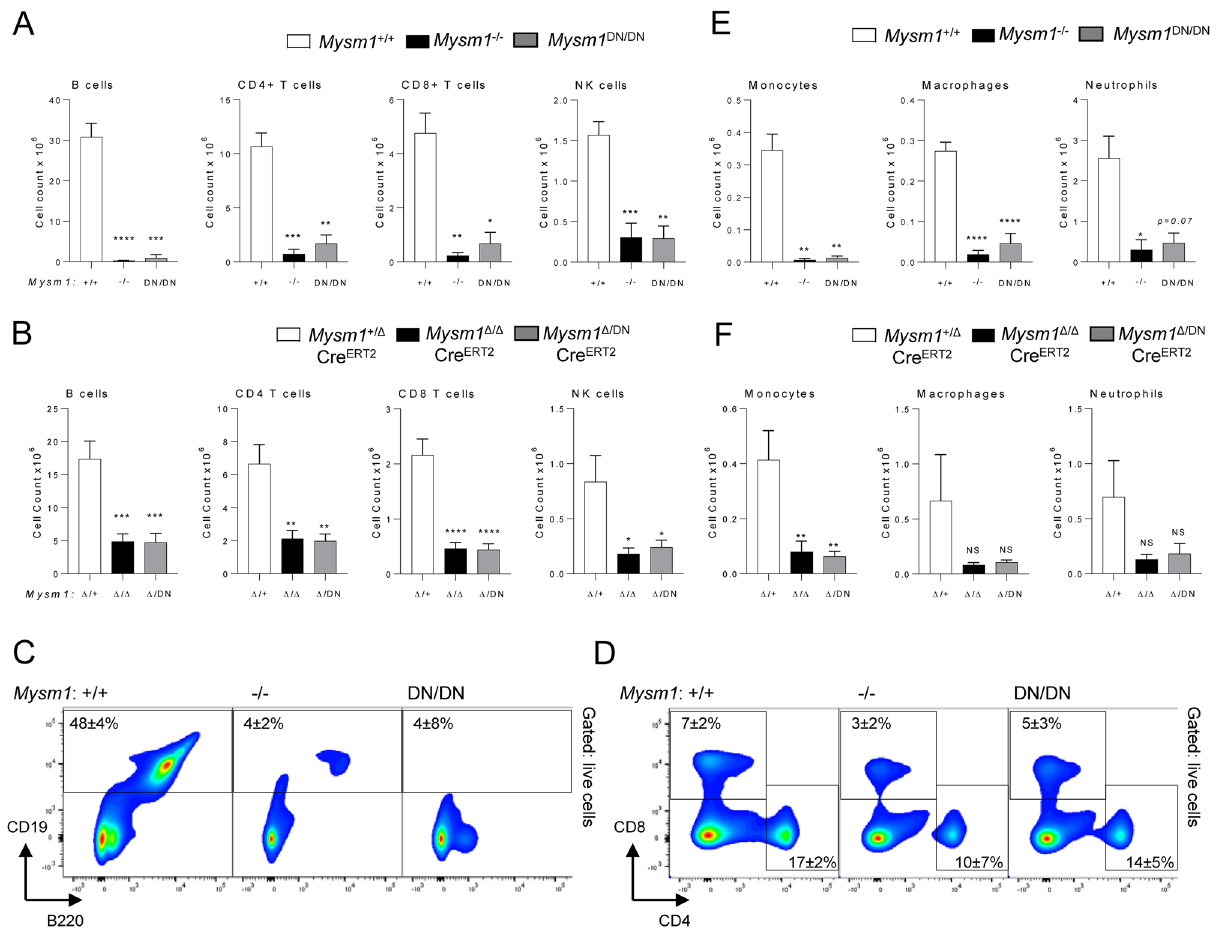
Figure 3. Depletion of splenic lymphoid and myeloid immune cells with the loss of MYSM1 DUB catalytic activity. Flow cytometry analyses were performed on ( A , C–E ) Mysm1 +/+ , Mysm1 −/− , and Mysm1 DN/DN mice, and ( B , F ) Cre ERT2 transgenic mice of Mysm1 fl/+ , Mysm1 fl/fl , and Mysm1 fl/DN genotypes at > 20 weeks after tamoxifen treatment, to quantify ( A , B ) B cells (CD19 + CD3 − ), CD4 T cells (CD3 + CD4 + CD8 − ), CD8 T cells (CD3 + CD4 − CD8 + ), NK cells (CD3 − NK1.1 + ), and ( E , F ) monocytes (CD45 + CD3 − NK1.1 − CD11b + Ly6C + Ly6G − ), macrophages (CD45 + CD3 − NK1.1 − CD11b + Ly6G − Ly6C − F4/80 + CD64 + ), and neutrophils (CD45 + CD3 − NK1.1 − CD11b + Ly6G + Ly6C − ). The data is from ( A,E ) 3–10 mice per genotype consolidated from two independent experiments, or ( B,F ) 8–11 mice per genotype consolidated from three independent experiments. Bars represent means ± SEM; statistical analysis with ANOVA and Dunnett’s post-hoc test, comparing each group to the control, * p < 0.05, ** p < 0.01, *** p < 0.001, **** p < 0.0001, NS—not significant. ( C , D ) Representative flow cytometry plots of the spleen of Mysm1 +/+ , Mysm1 −/− , and Mysm1 DN/DN mice gated on live cells and showing the depletion of ( C ) CD19 + B cells and ( D ) CD4 + and CD8 + T cells in Mysm1 −/− and Mysm1 DN/DN mice; the average frequencies of cells in the gates are presented as mean ± st.